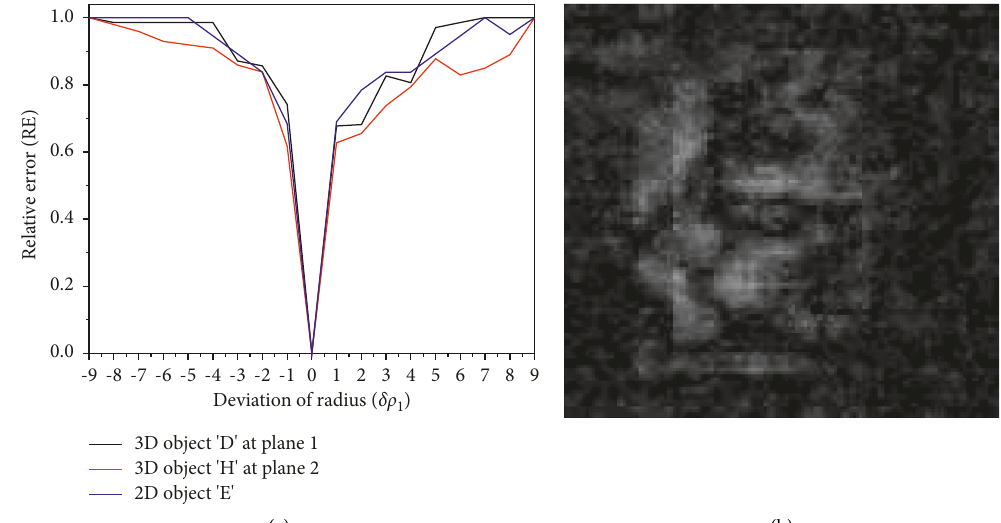
� 6 . 1 ° ; (c), (d) reconstructed 3D object with wrong angle φ 2